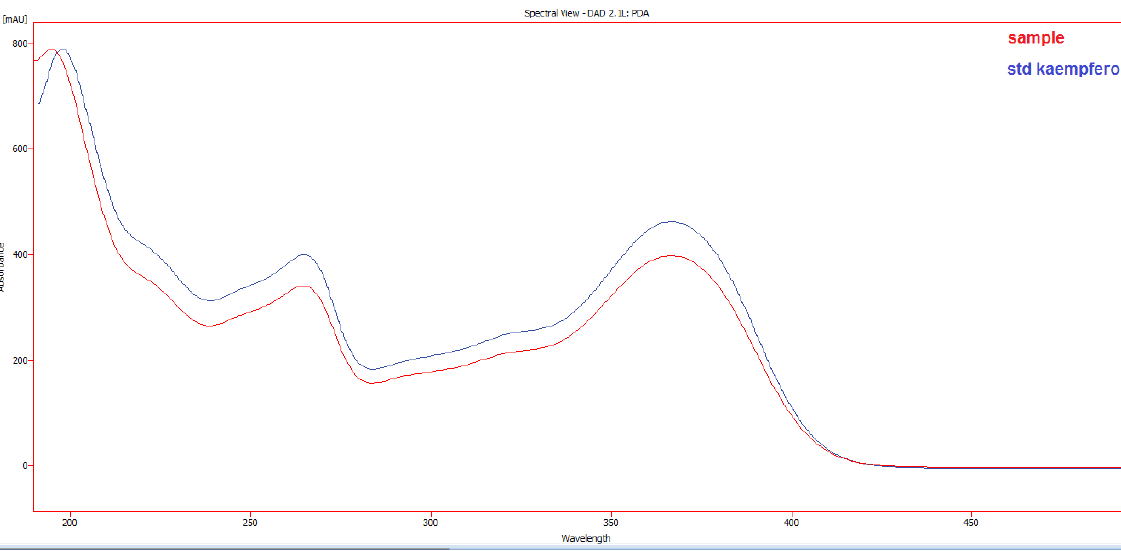
Figure 7. UV spectrum of fraction of ethyl acetate matched with kaempferol standard UV spectrum.